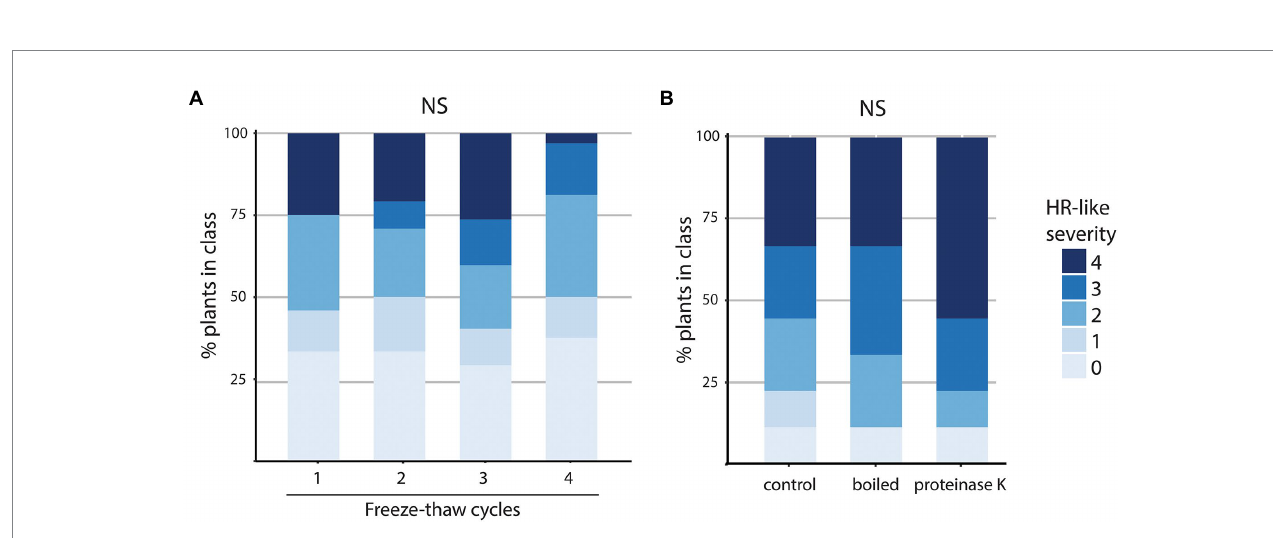
FIGURE 6 Proportion of HR-like cell death induced by differently treated egg washes made of Pieris brassicae eggs in Brassica nigra . (A,B) Severity of HR-like symptoms induced in plants by the different washes. (A) Egg washes that were subjected to increasing amount of freeze–thaw cycles. N plants/ treatment = 24–32. NS (B) Egg washes subjected to boiling (95 ° C for 30 min) or incubated with proteinase K. N plants/treatment = 9. NS, not significant, Kruskal–Wallis